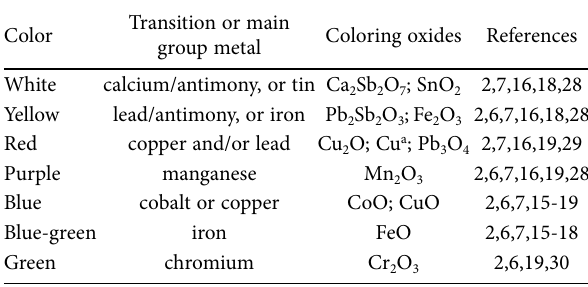
Table 1. Colorants commonly employed in early silica glasses.